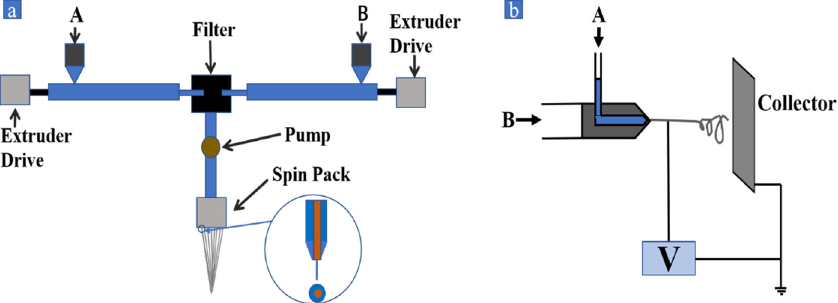
Figure 2: Schematic diagram of the preparation of core/shell bicomponent fi bers: ( a ) spun bonding and ( b ) electrospinning. ( a ) Adapted with permission ( 91 ) Copyright 2011, Springer Science Business Media; ( b ) adapted with permission ( 100 ) Copyright 2004, American Chemical